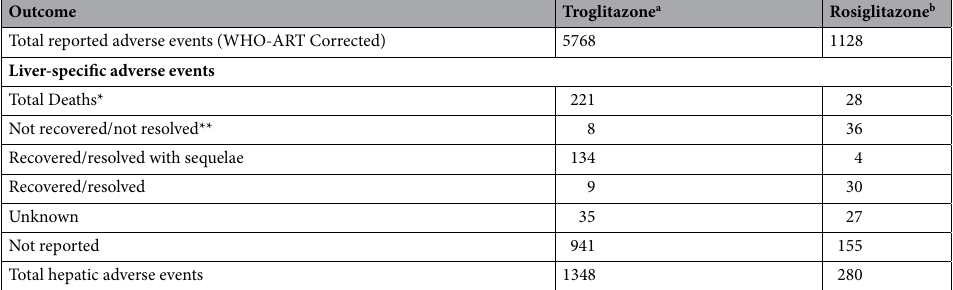
Table 3. Comparison of hepatic and non-hepatic adverse events reported in the first 4 years following market release. *To calculate Total Deaths, MedDRA terms for Death (Event may have contributed), Death (Cause of death other than event), Fatal (Cause of death is event) were added; **WHO controlled vocabulary definitions can be found, e.g. in https:// www. who. int/ medic ines/ publi catio ns/ Pharm aco_ TB_ web_ v2. pdf. a Troglitazone adverse events reported from 1998–2001. b Rosiglitazone adverse events reported from 2000–2003.